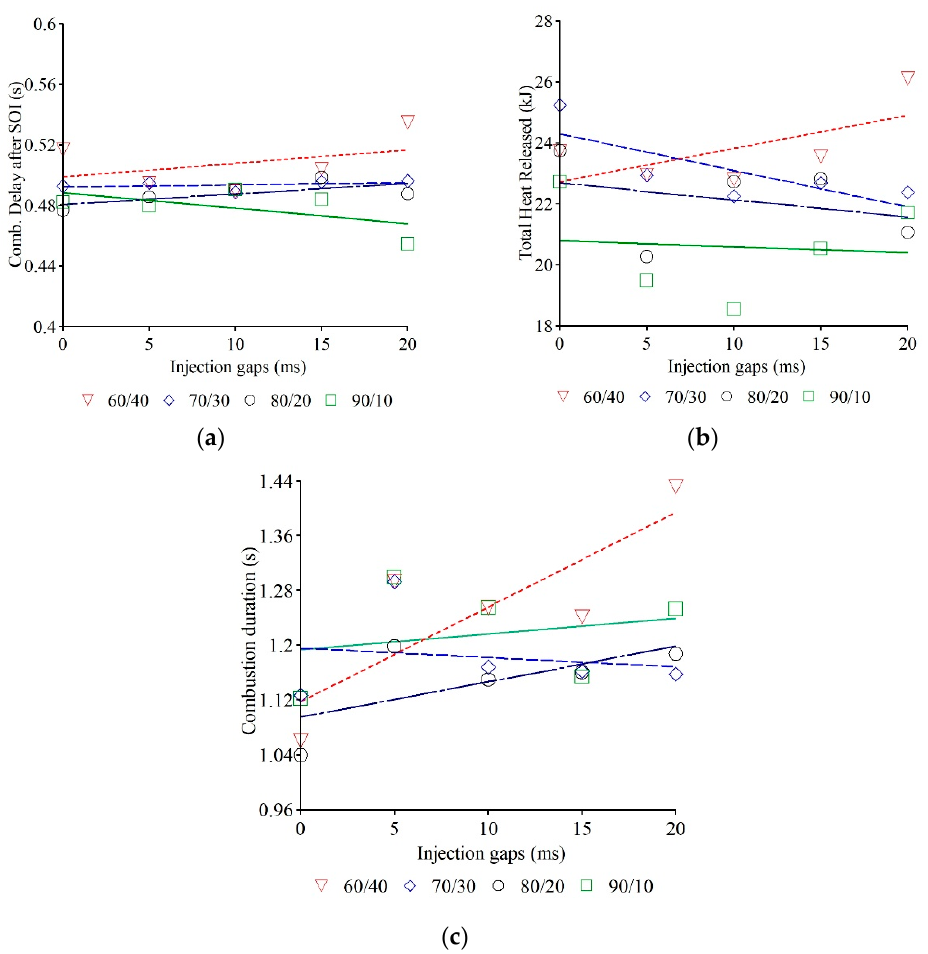
Figure 8. Effect of injection gaps to the combustion delay for various mixture compositions ( a ); total heat released ( b ) and combustion duration ( c ) on various mixtures of diesel/CNG.